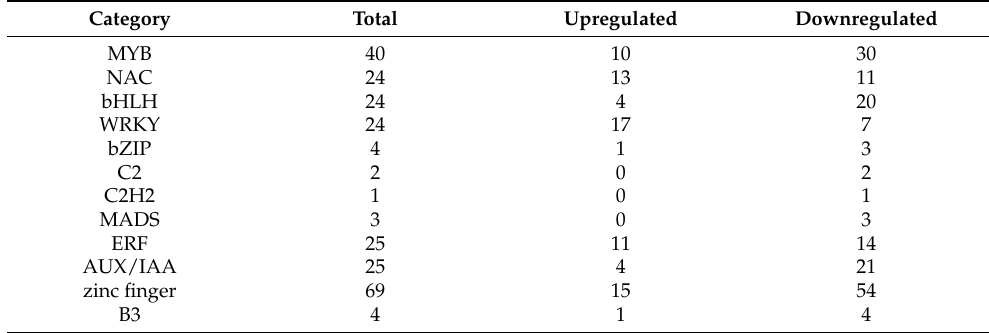
Table 4. Response of transcription factors in comparison of A1 vs.